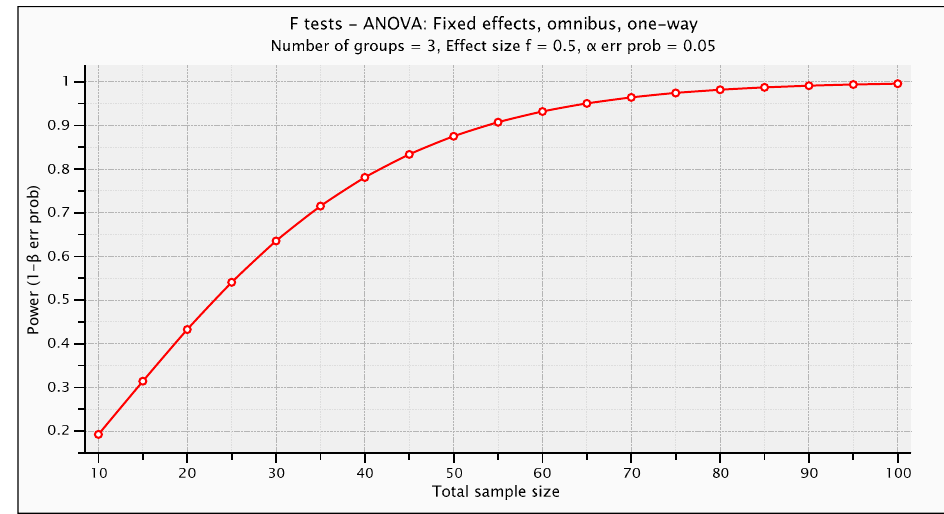
Figure 3. Sample size determination.